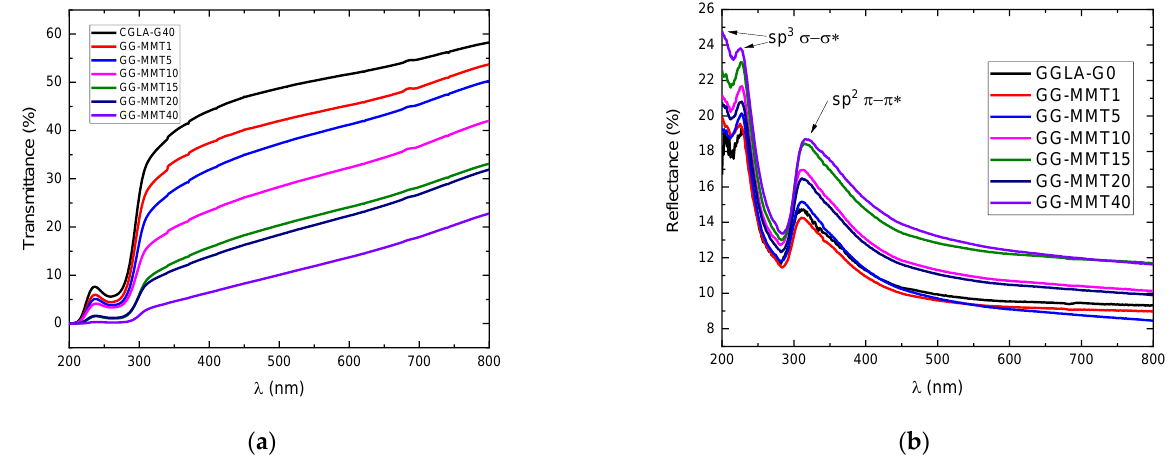
Figure 5. DRX diffractograms of Na + SYN-1 clay; GGLA-G0 and GGLA-G40 SPEs; and GG-MMT1 to GG-MMT40 NPEs.